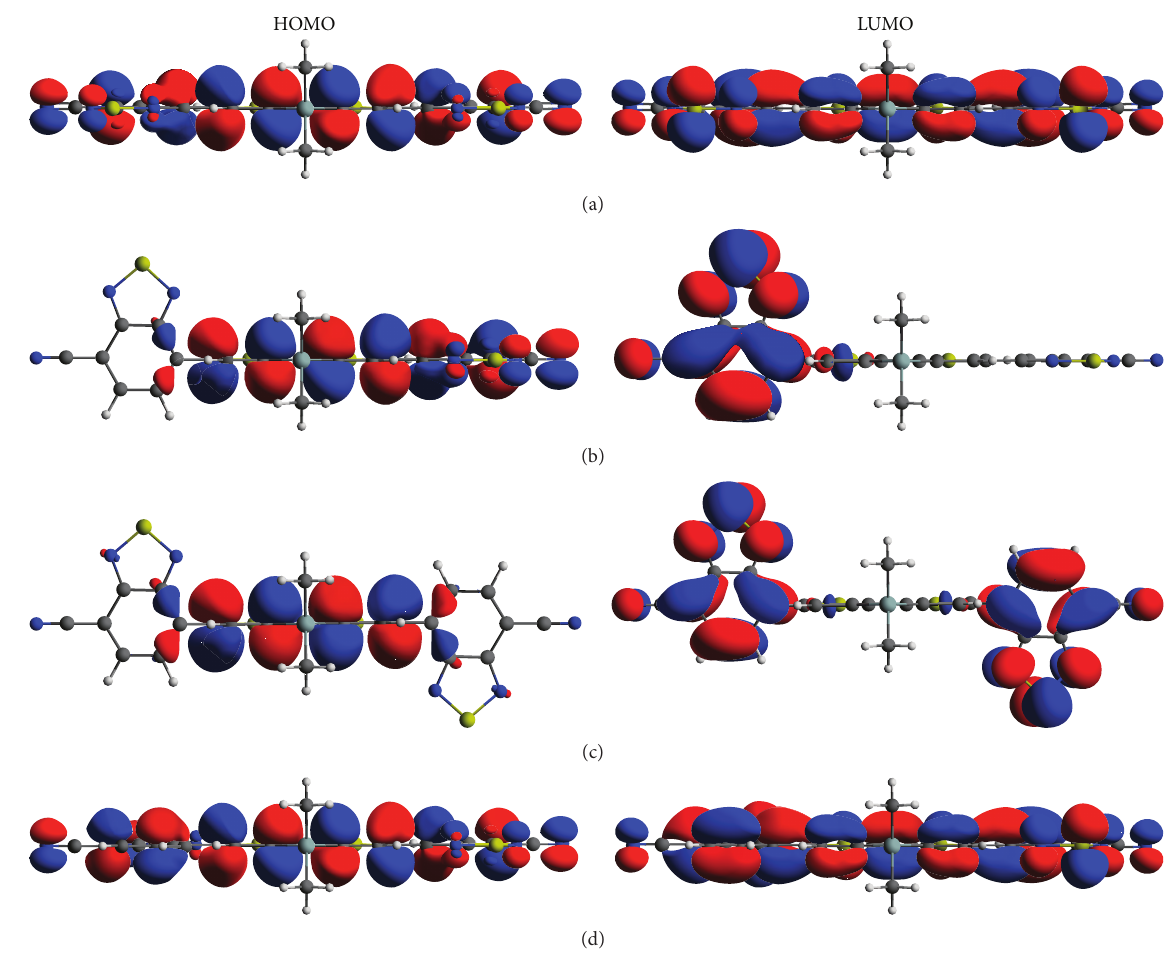
Figure 5: Images of frontier molecular orbitals of the BCNDTS molecule at (a) 𝛼 = 𝛽 = 0 ∘ , (b) 𝛼 = 0 , 𝛽 = 90 ∘ , (c) 𝛼 = 90 ∘ , 𝛽 = 90 ∘ , and (d) 𝛼 = 180 ∘ , 𝛽 = 0 ∘ . Red and blue colors represent negative and positive phases of the orbitals,